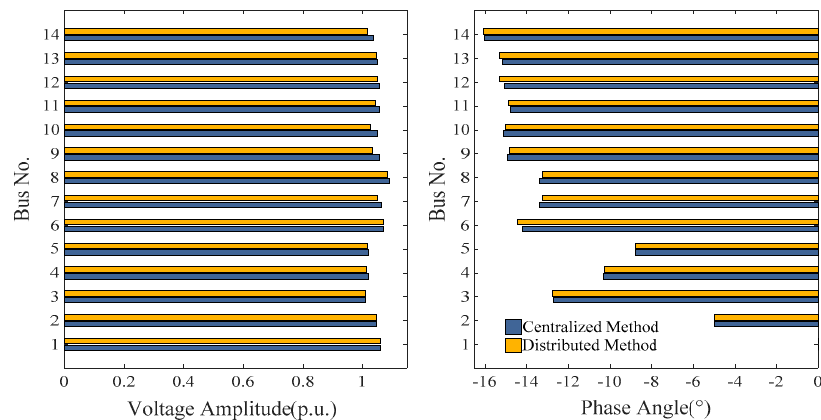
Figure 4. Voltage amplitude and angle comparisons of distributed and centralized method for the IEEE 14-bus system.